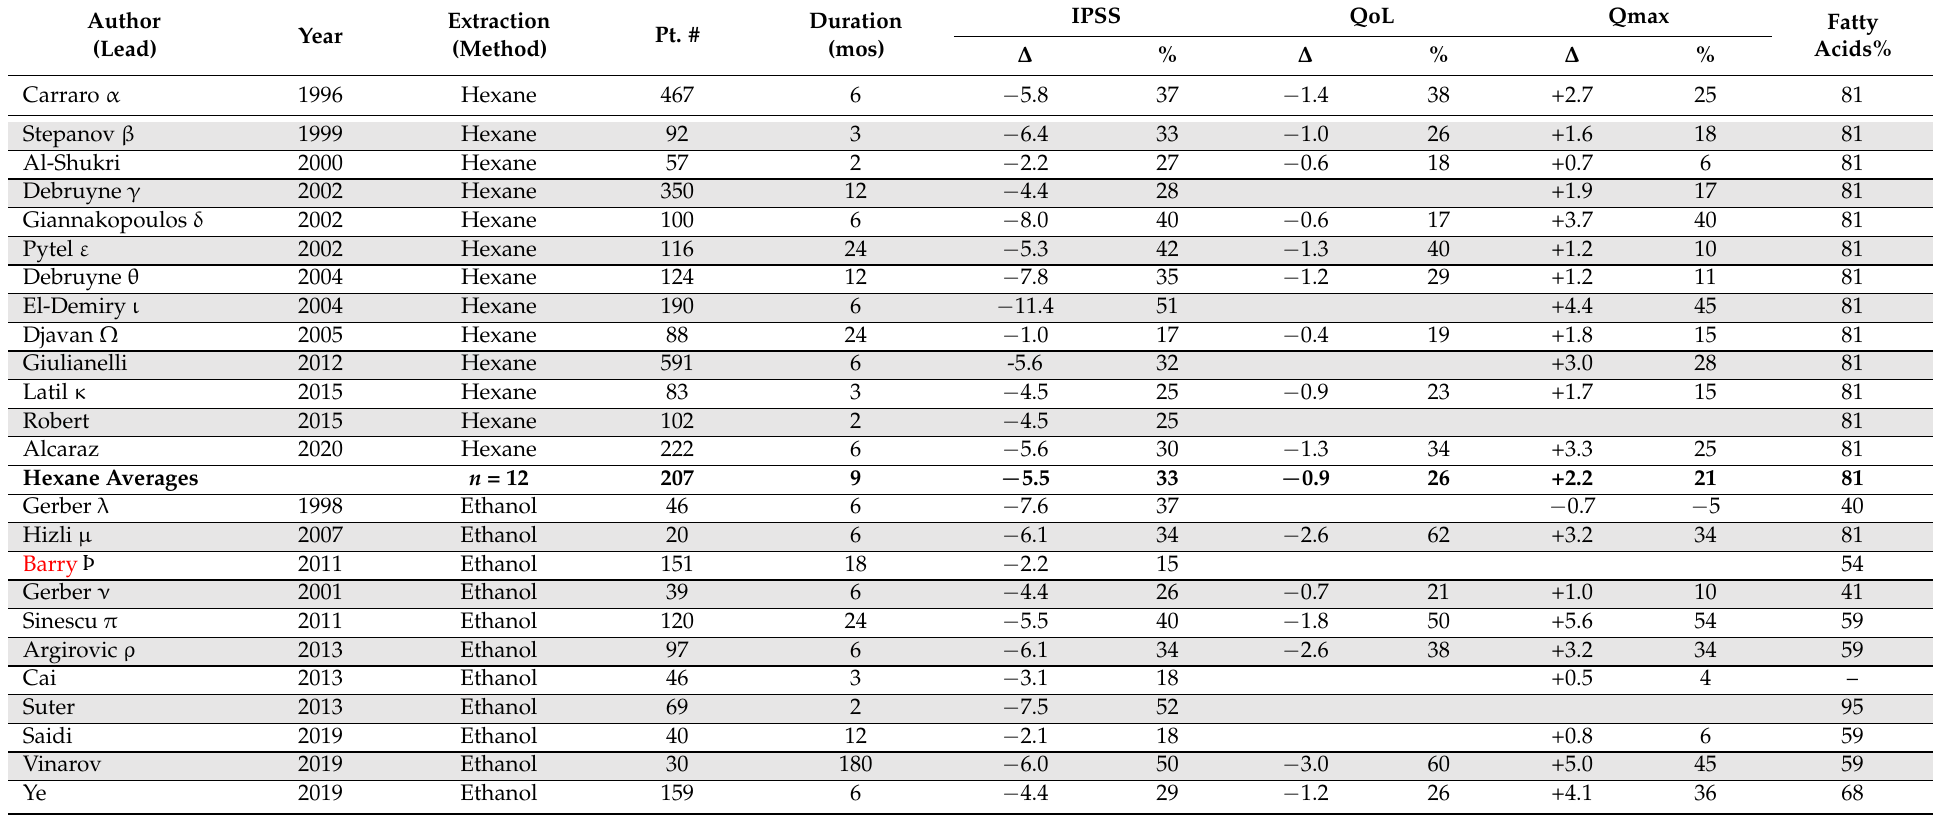
Table 5. Thirty-one LSESr vs. LUTS English-language studies meeting evaluability criteria. The three negative studies are shown in red